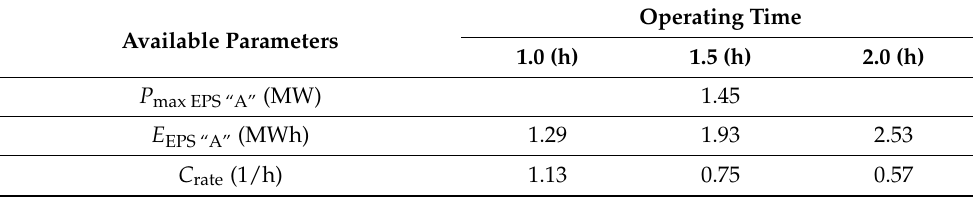
Table 5. Active power P and energy E of the considered EPS “A” in the normal operation N. Available